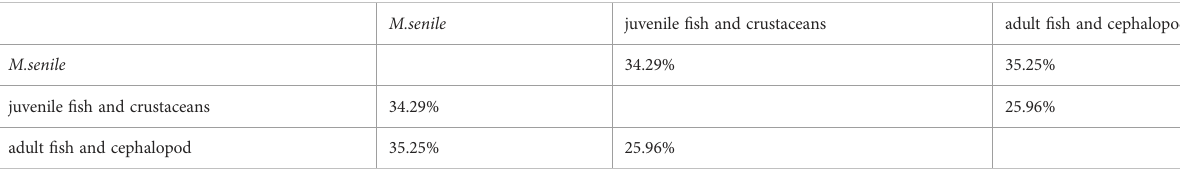
TABLE 3 Area of overlap between small sample size-corrected SIBER ellipses of different functional